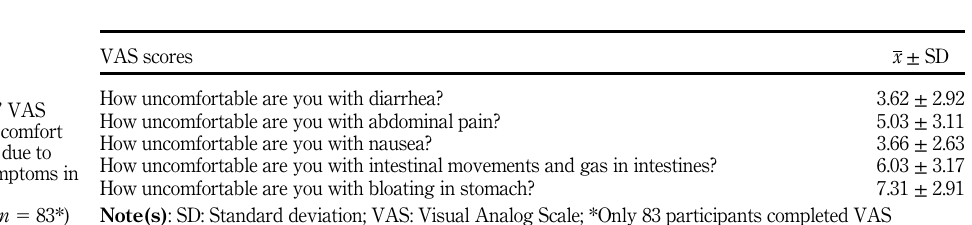
Table 3. Quality of life scale subscores of the individuals with lactose intolerance ( n 5 140*)